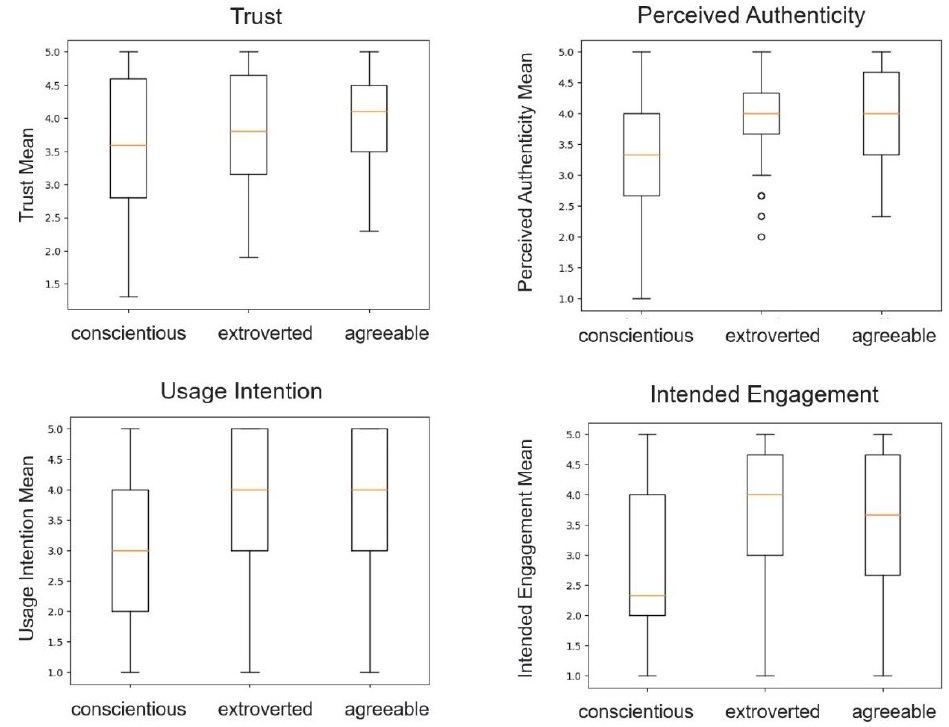
Figure 5. A box plot for the students ’ ratings of the chatbots.